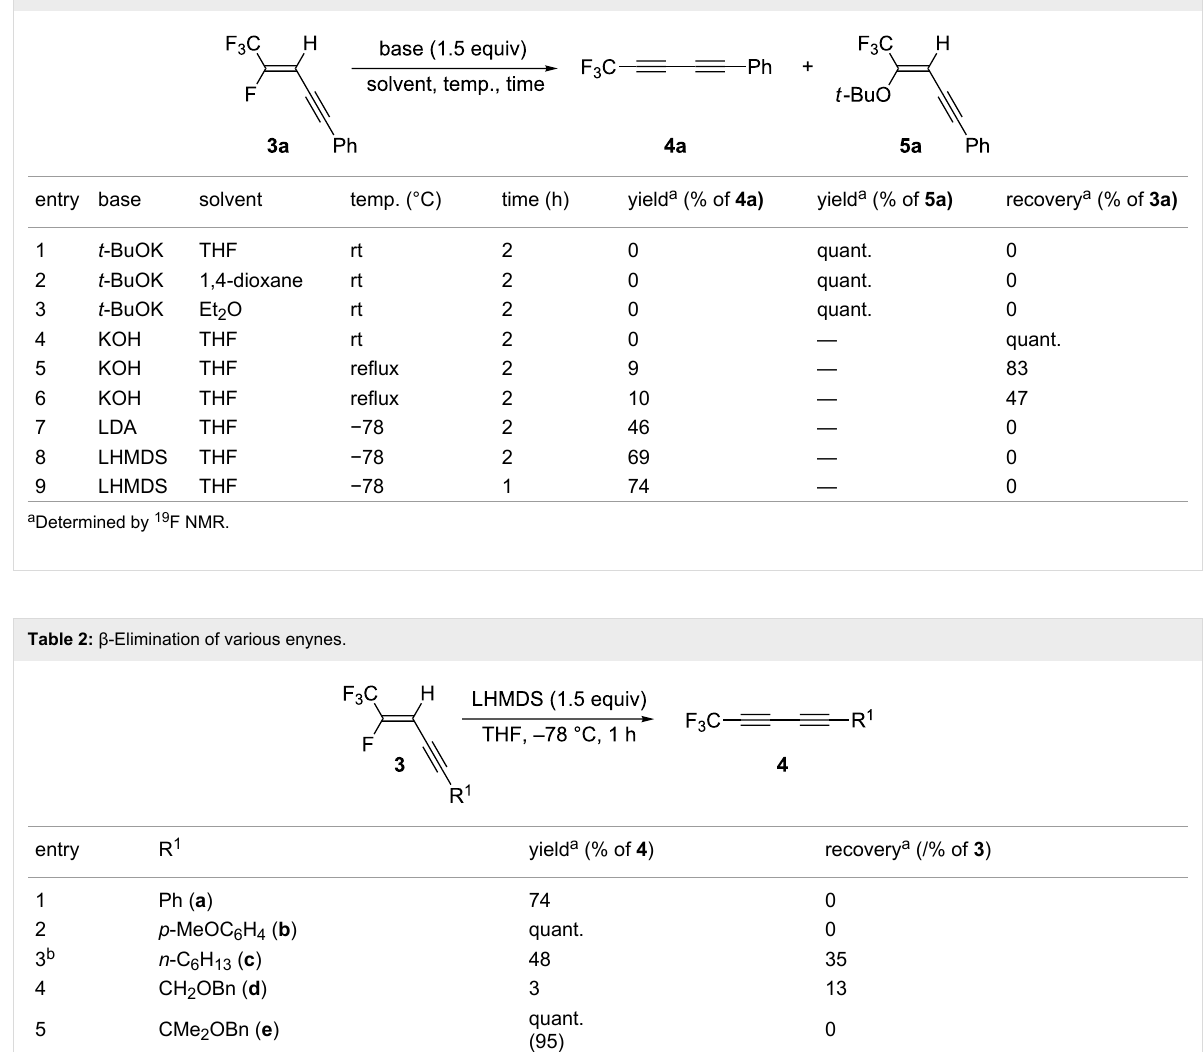
Table 1: Investigation of the reaction conditions.